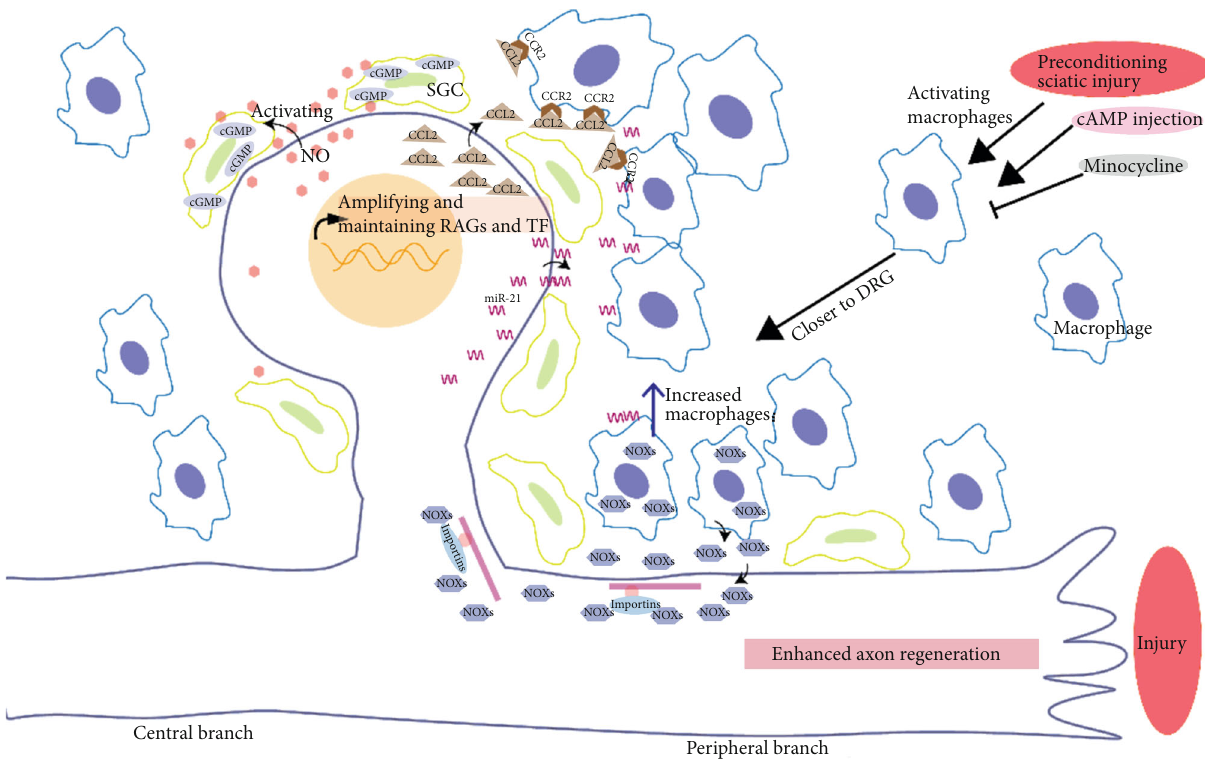
Figure 3: Interaction between neurons and nonneurons after PNS preconditioning injury. The preconditioning sciatic nerve injury increased the number of macrophages and in fl ammatory mediators and drives macrophage activation toward DRG. The interactions amplify and maintain RAGs and TF expression to enhance axon regeneration. SGC: satellite glial cells; CCL2:C-C motif chemokine ligand 2; CCR2: C- C motif chemokine receptor 2; NOXs: NADPH oxidase 2